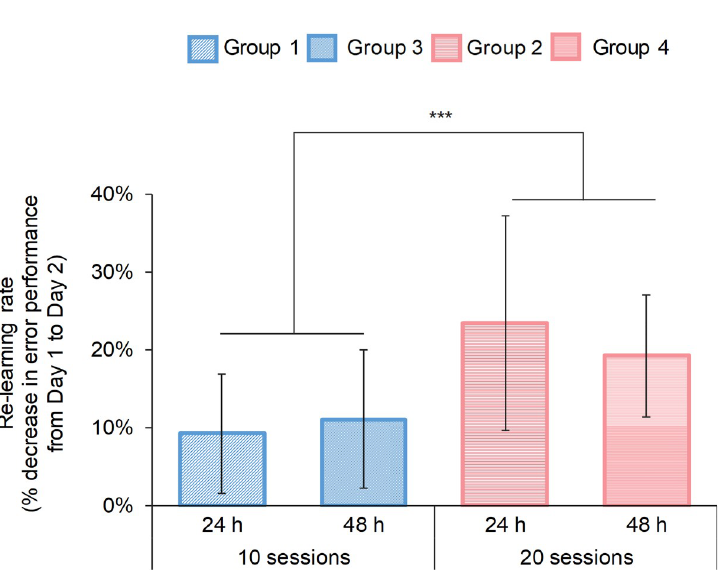
Fig 6. Savings in the experimental groups. The vertical axis represents savings. The savings of the 20-session groups (Group 1, Group 3) was greater than that of the 10-session groups (Group 2, Group 4). A two-way ANOVA with the time interval (24 h, 48 h) and the amount of training on Day 1 (20 sessions, 10 sessions) as between-subject factors revealed the main effect of the amount of training ( F (1,36) = 12.89, p < 0.001, η p 2 = 0.26). There was no significant interaction. The savings values marked with asterisks were significantly higher in the 20-session practice groups than in the 10-session practice groups (all p s < .001).